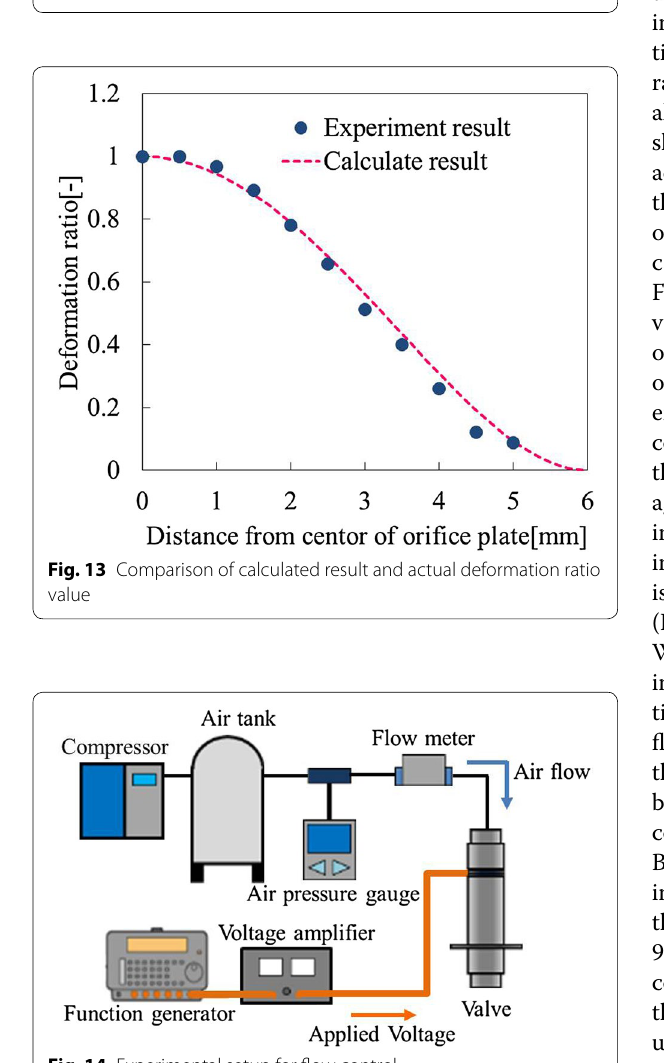
Fig. 12 Relationship between applied voltage and prototype’s acceleration